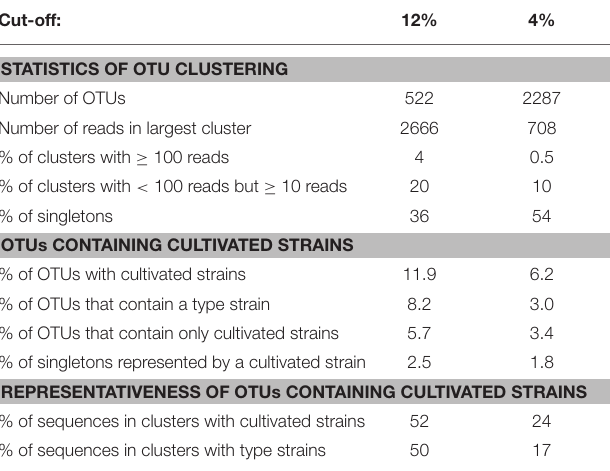
TABLE 6 | Statistics about OTU clustering and distribution of pmoA sequences of cultivated methanotrophic strains within these clusters. Cut-off: